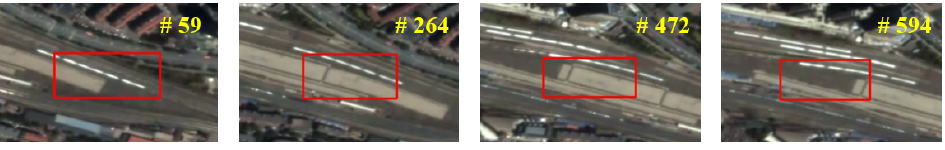
Figure 11. Partial occlusion and poor target-background discriminability cause loss of object size